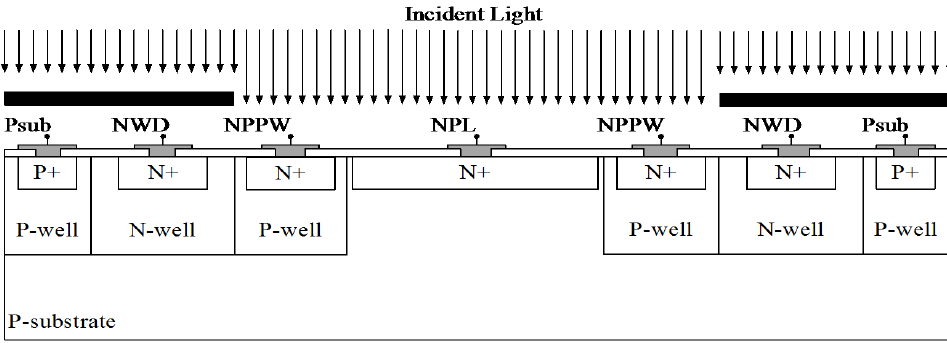
Figure 4. Cross-section of the proposed color sensor structure with three-sensor output signals NPL, NWD, and NPPW with different spectral